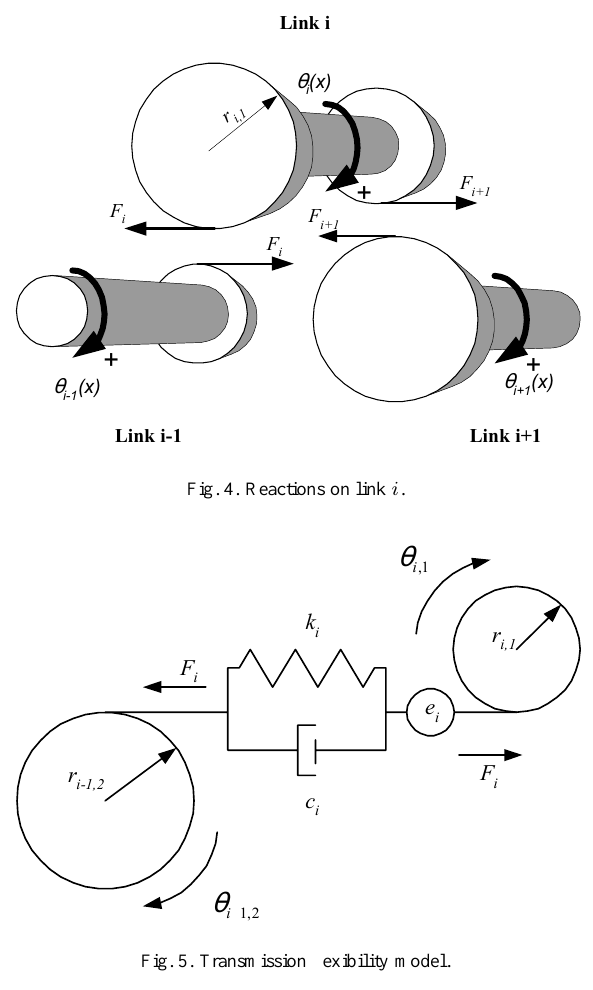
Fig. 5. Transmission flexibility